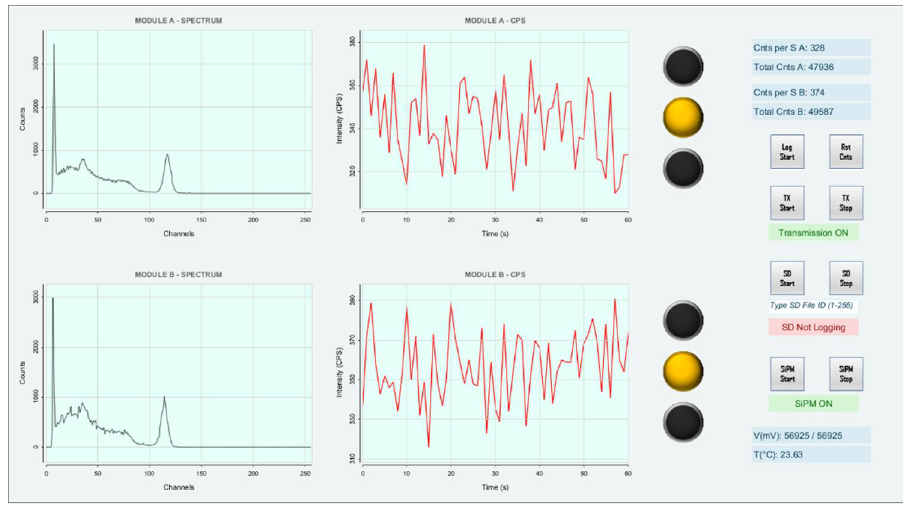
Figure 6. Graphical user interface.